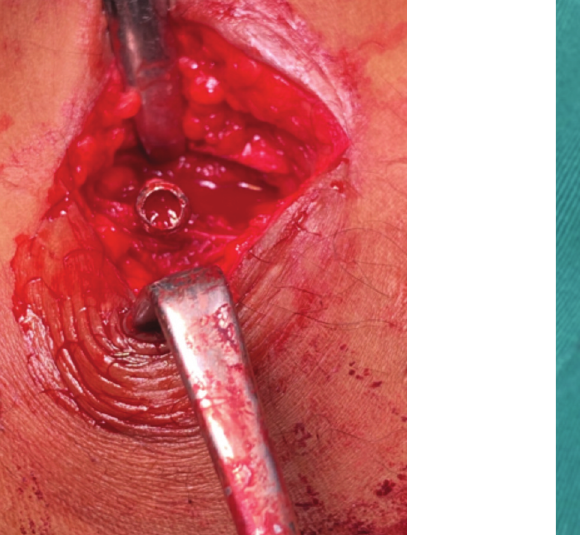
Two straight and parallel planes formed on the screw Fig. 2: head using the high speed diamond-tipped